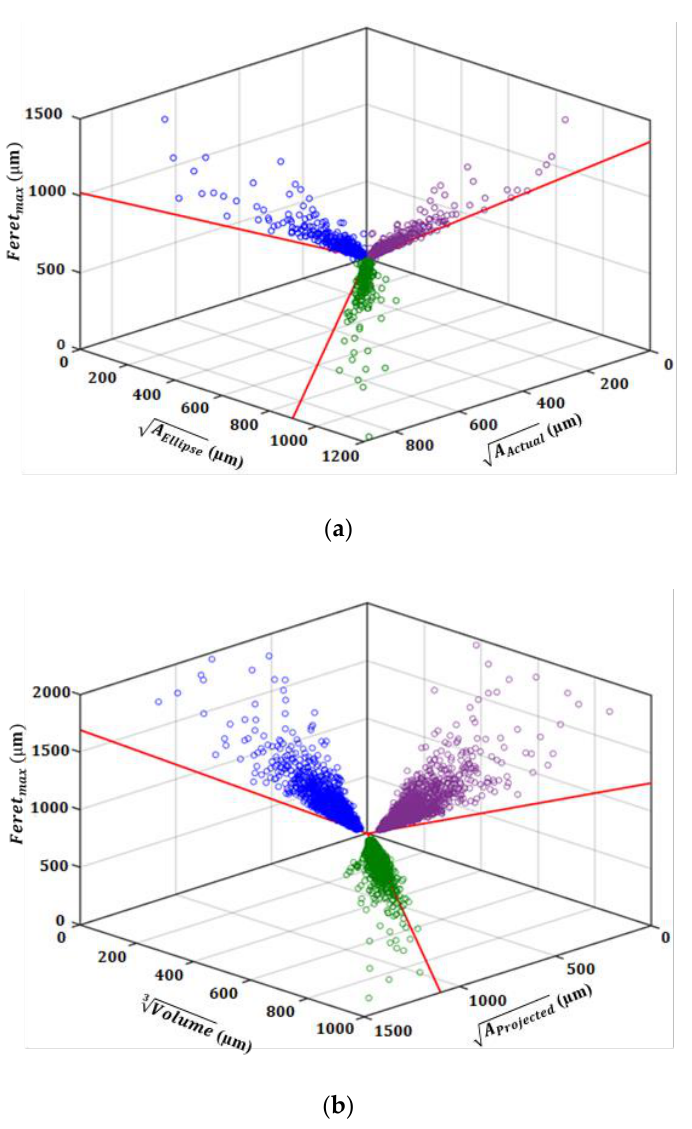
Figure 4. Comparison of different defect parameters; ( a ) metallography and ( b ) µCT scan evaluation. The solid diagonal lines pertain to the ideal spherical (circular) defect.